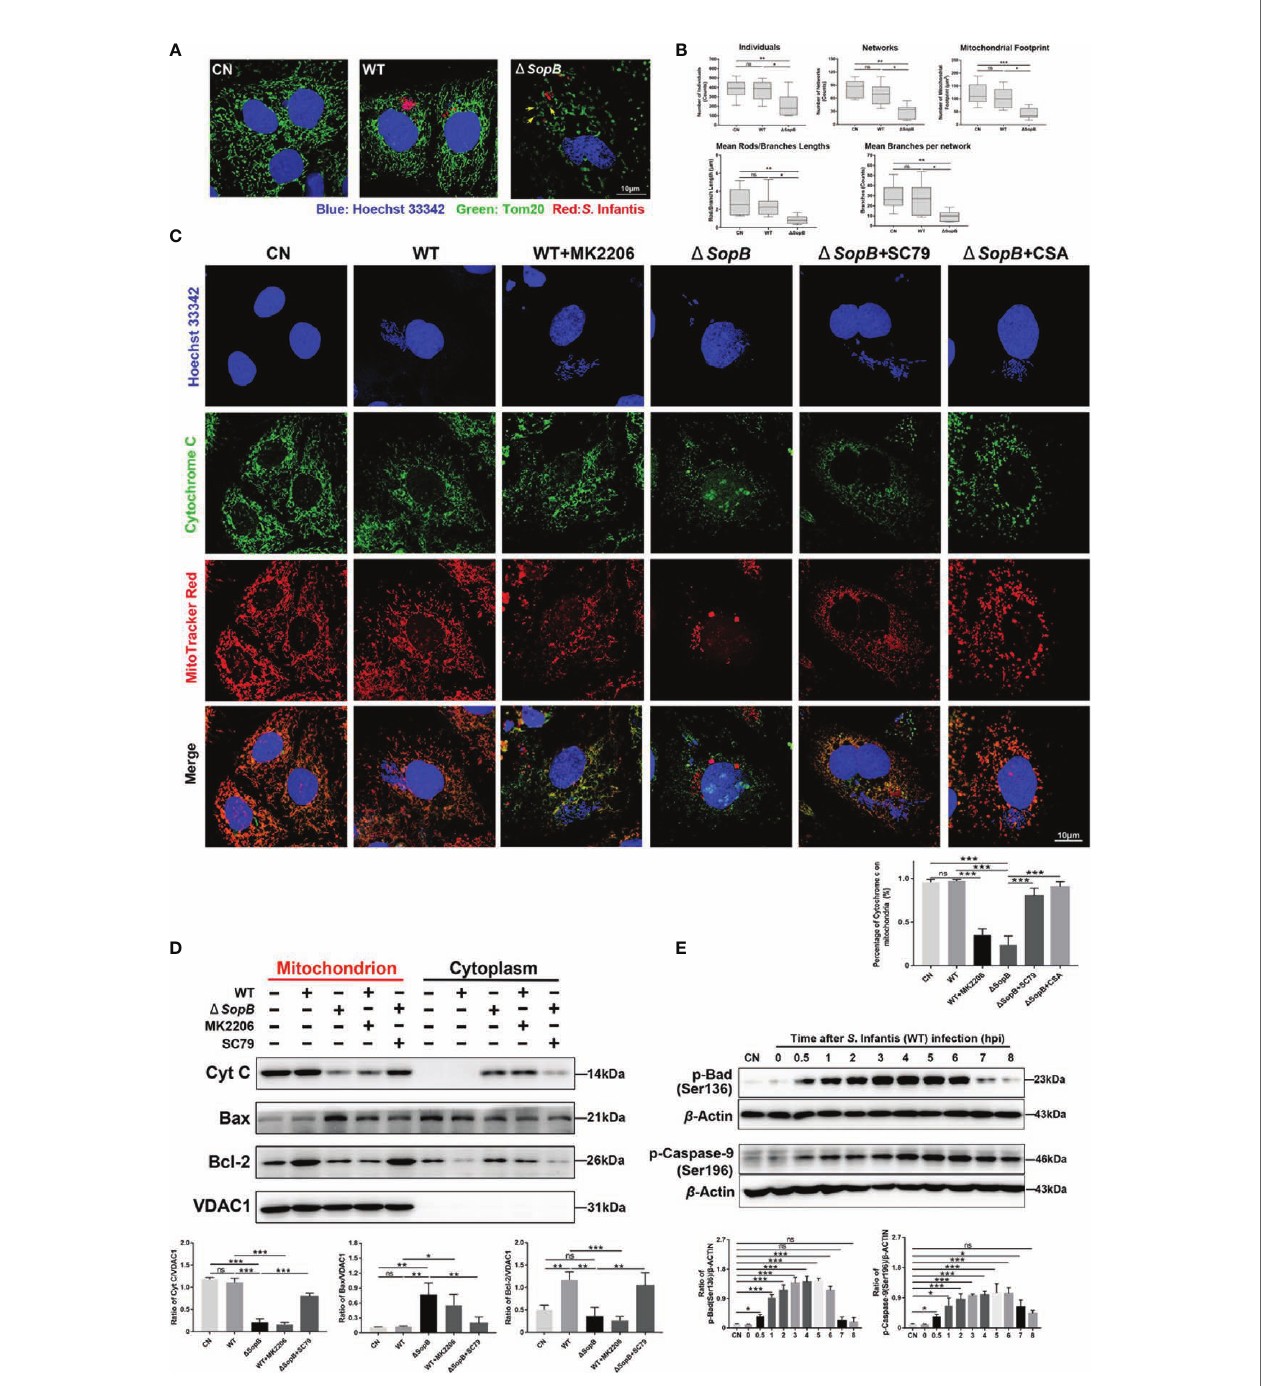
FIGURE 4 | SopB -mediated Akt phosphorylation inhibited apoptosis by maintaining mitochondrial dynamic network homeostasis. In (A – D) , all cell samples were collected and processed at 4 hpi after infection with S . Infantis. Immuno fl uorescence analysis of mitochondrial network after infection with WT S . Infantis or the SopB mutant. Red: Salmonella ; Green: Tom20 (mitochondria); Blue: Hoechst 333342. (B) Mitochondrial network analysis using the MiNA toolset of Image (J) (C) Co- localization of cytochrome c and mitochondria was detected using immuno fl uorescence. In the bacterial infection process, the phosphorylation level of Akt was regulated by the addition of MK2206 or SC79. CSA was used to inhibit the opening of the mitochondrial permeability transition pore (MPTP) Red: Mitochondria; Green: Cytochrome c; Blue: Hoechst 333342 (Nucleus and bacteria). (D) Detection of Cytochrome c, Bcl-2, and Bax protein levels in mitochondrial and cytoplasmic protein after infection with WT S . Infantis or the SopB mutant. In the bacterial infection process, the phosphorylation level of Akt was regulated by the addition of MK2206 or SC79. (E) Western blot analysis of p-Caspase-9 (Ser136) and p-Bad (Ser196) protein expression levels within 8 h after infection with S . Infantis. Data were presented as the mean ± SEM from three independent experiments (n = 3). * P < 0.05, ** P < 0.01, *** P < 0.001. CN, control. ns, no signi fi cant